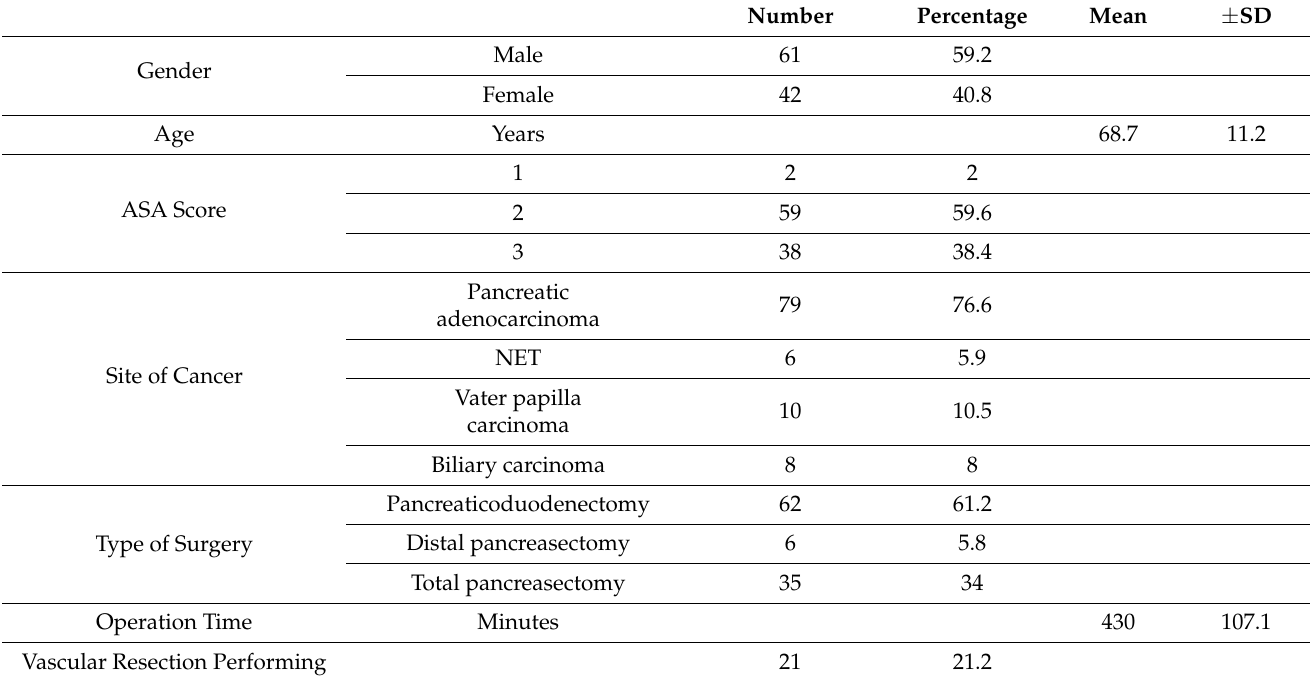
Table 1. General characteristics.